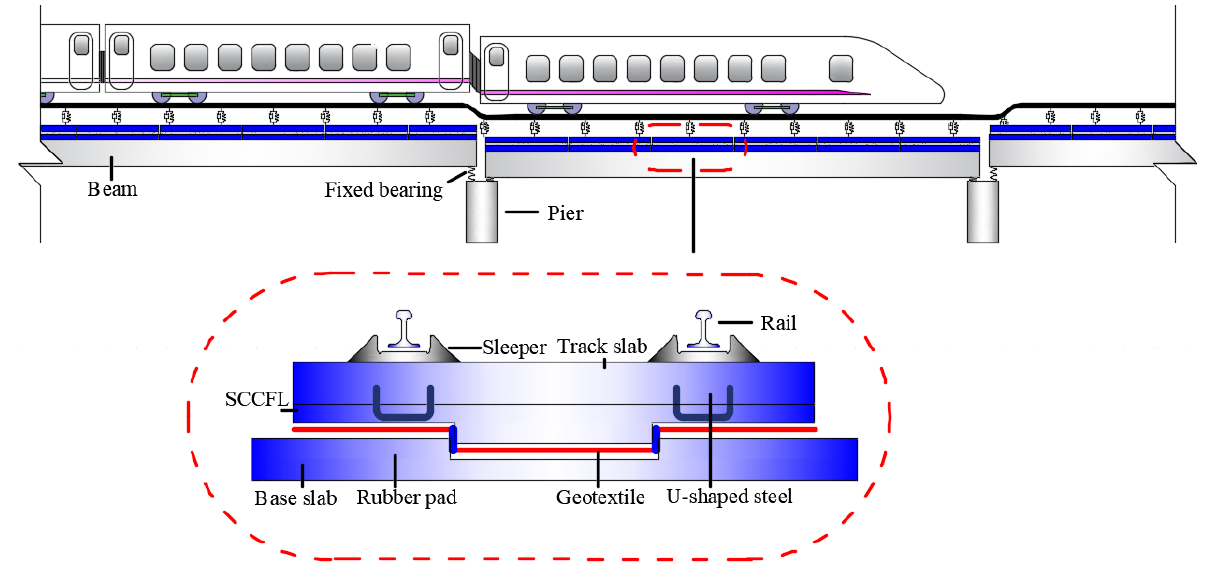
Figure 1. Schematic diagram of the CRTS Ⅲ SBT structure.